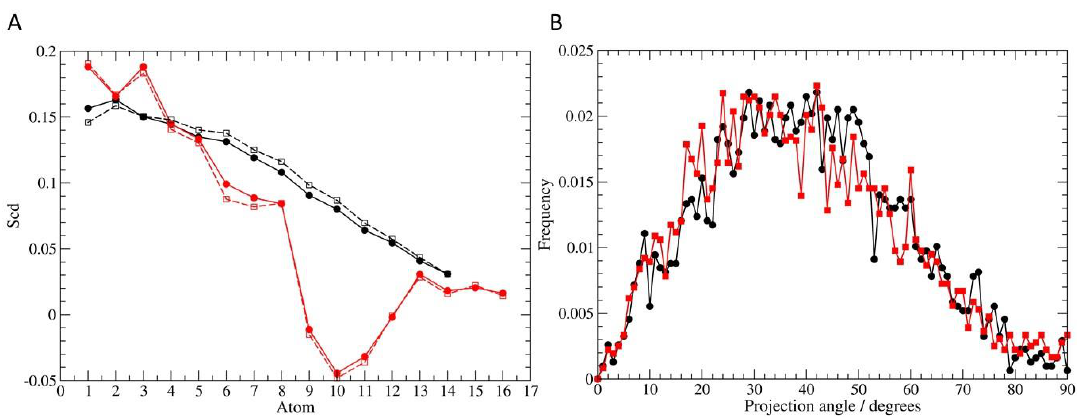
Figure 10. Degree of lipid reorientation and overall disorder in the bilayer. ( A ) Deuterium order parameter S CD values were calculated for acyl chains sn1 (black) and sn2 (red). The filled circles and squares represents the order at the first 10 ns of simulation, while the empty circles and squares are the values for the last 10 ns; ( B ) Frequency distribution of the tilt angle of the lipid with the respect to the normal axis to the bilayer. The orientation values (0 ◦ = parallel to the z axis; 90 ◦ = perpendicular to the z axis) were also averaged for the initial 10 ns (black) and the final 10 ns